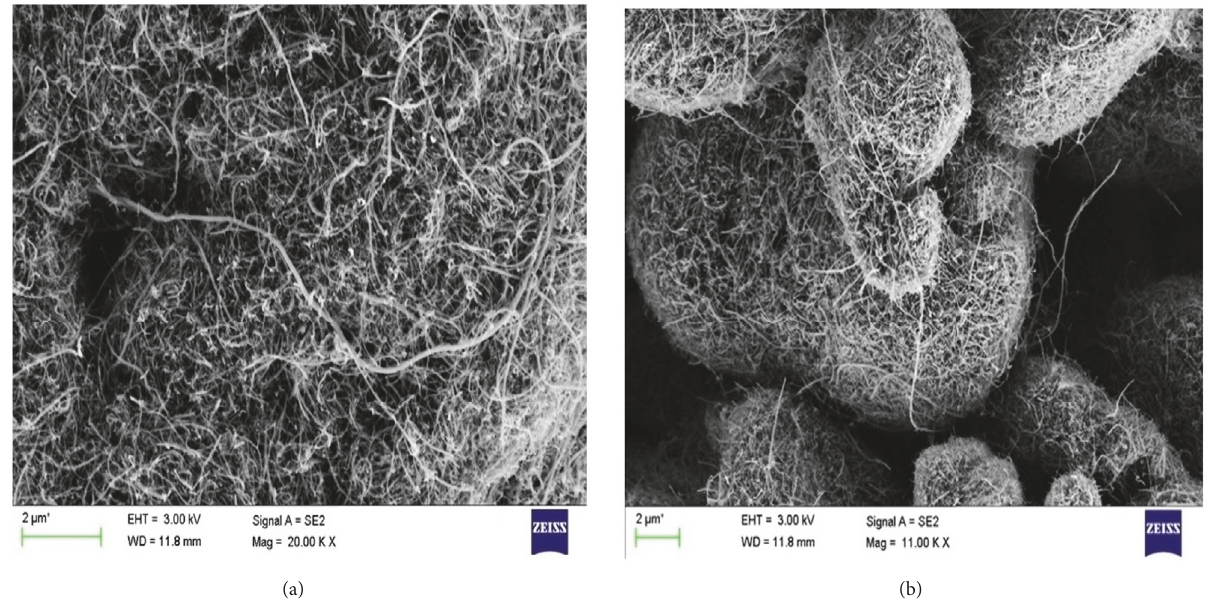
Figure 1: HRSEM images of pristine and 5-hour ball-milled MWCNTS. (a) Pristine MWCNTS, (b) 5-hour ball-milled MWCNTS.